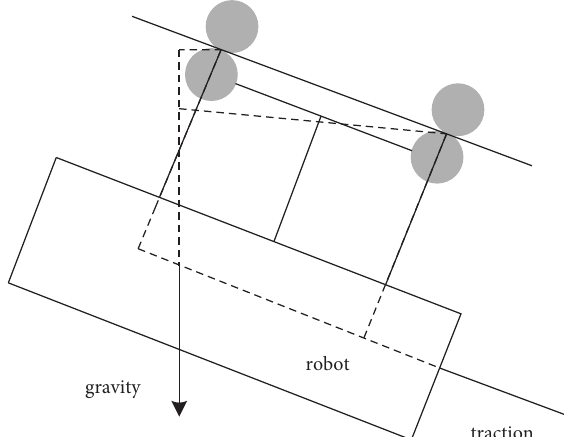
Figure 2: The torque to be overcome by the driving